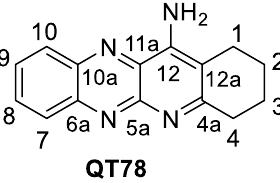
Figure 6. Structure of QT78 .